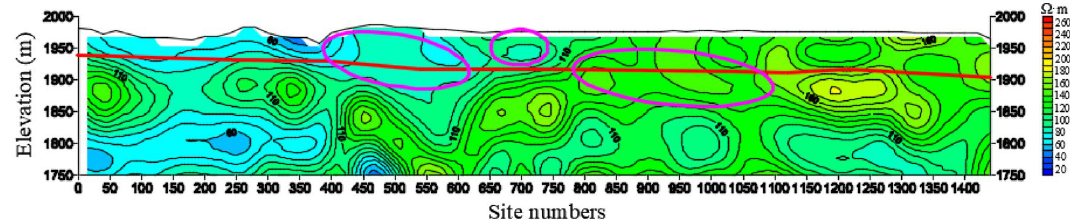
Figure 17. The resistivity profile of the TEM of 420 m mileage